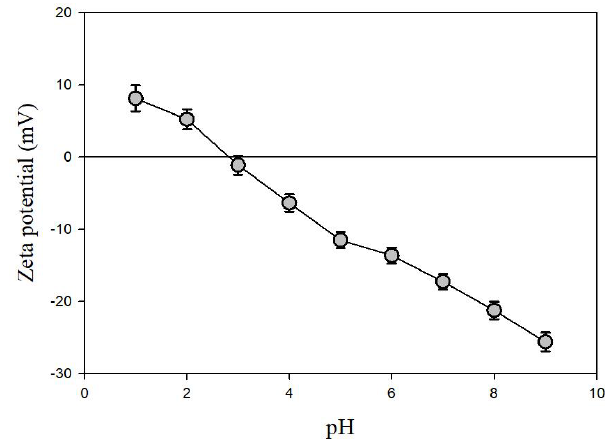
Figure 3. Zeta potentials of pyrrhotite used in the experiments.